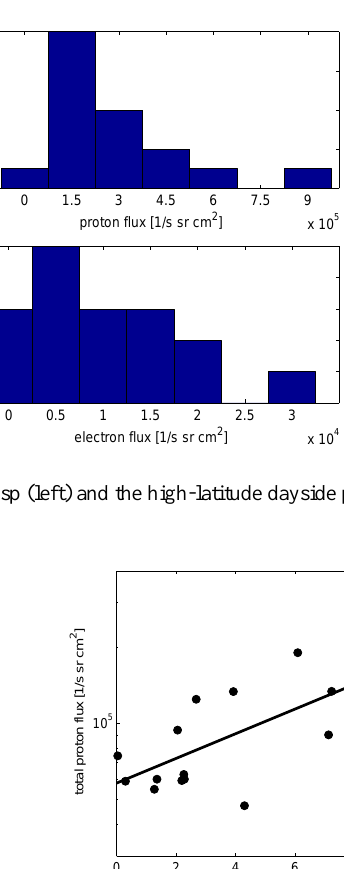
Fig. 3. Total proton fluxes observed in the exterior cusp as a func- tion of IMF | B y |